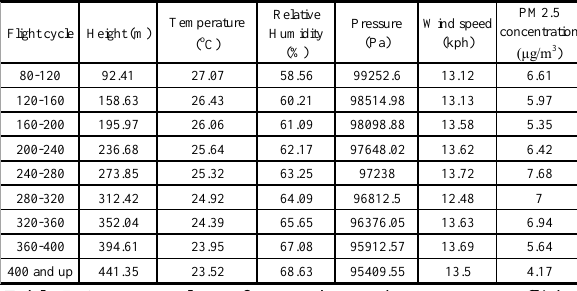
Flight cycle Height (m)